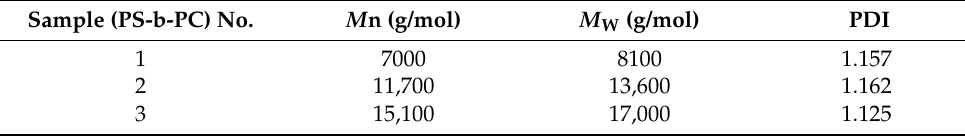
Table 2. The parameters of materials.